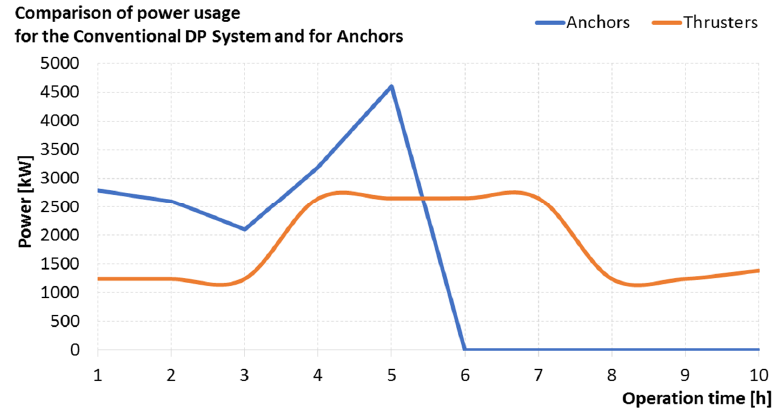
Figure 18. Comparison of the power of both systems.